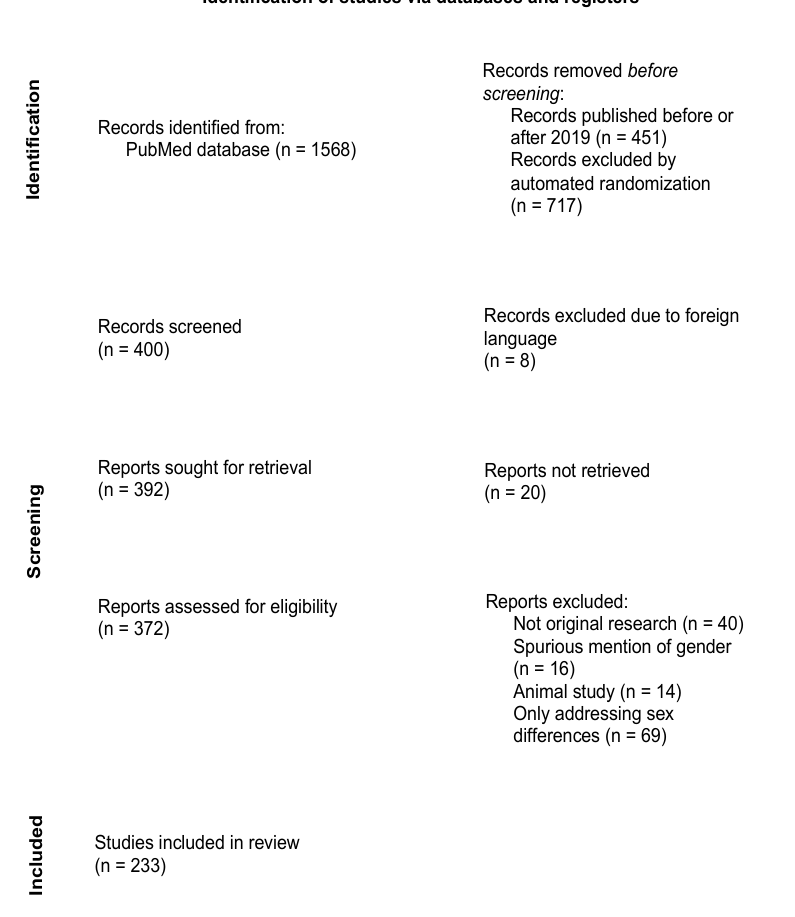
Figure 2. Representation of disciplinary groups and authorship patterns. All included articles were assigned to specific (bio)medical disciplines based on disciplinary affiliation of authors and MESH classifiers.